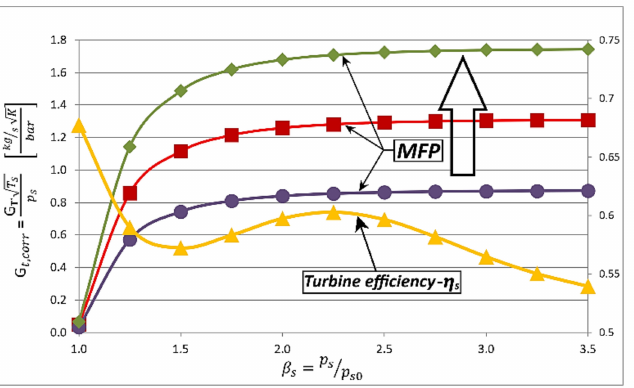
Figure 10. Performance of the exhaust gas turbine (mass flow parameter and efficiency as a function of pressure ratio).